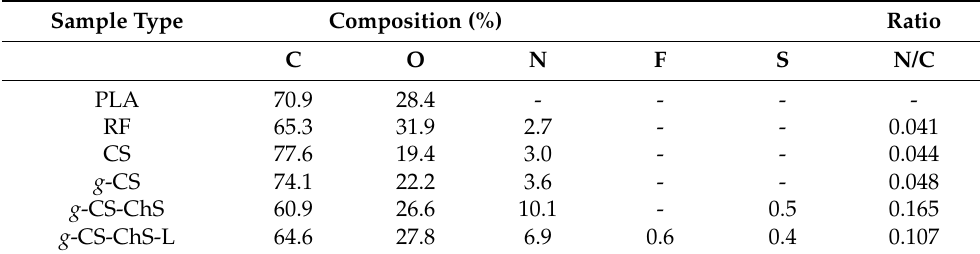
Table 2. The atomic weight percentage of unmodified and modified PLA